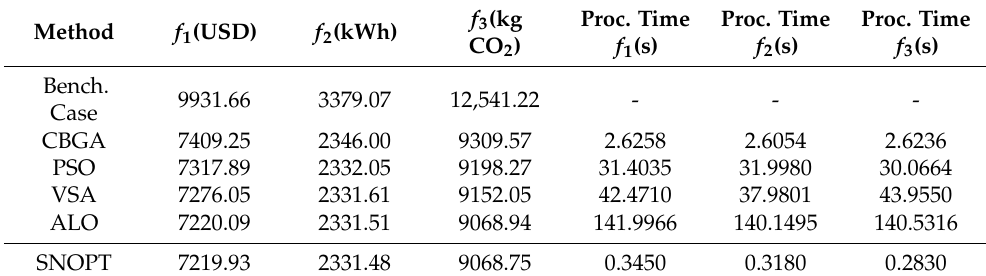
Table 7. Numerical results in the 33-bus system for the urban